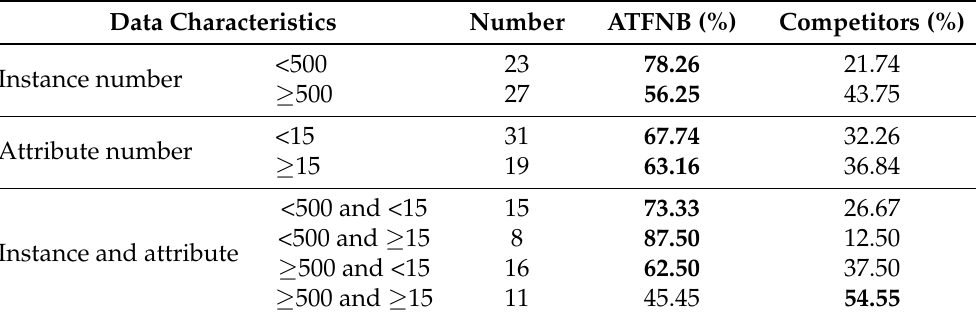
Table 13. ATFNB and competitors’ obtained percentage of datasets with the highest classification accuracy in each division. Bold text is to highlight the superiority of the